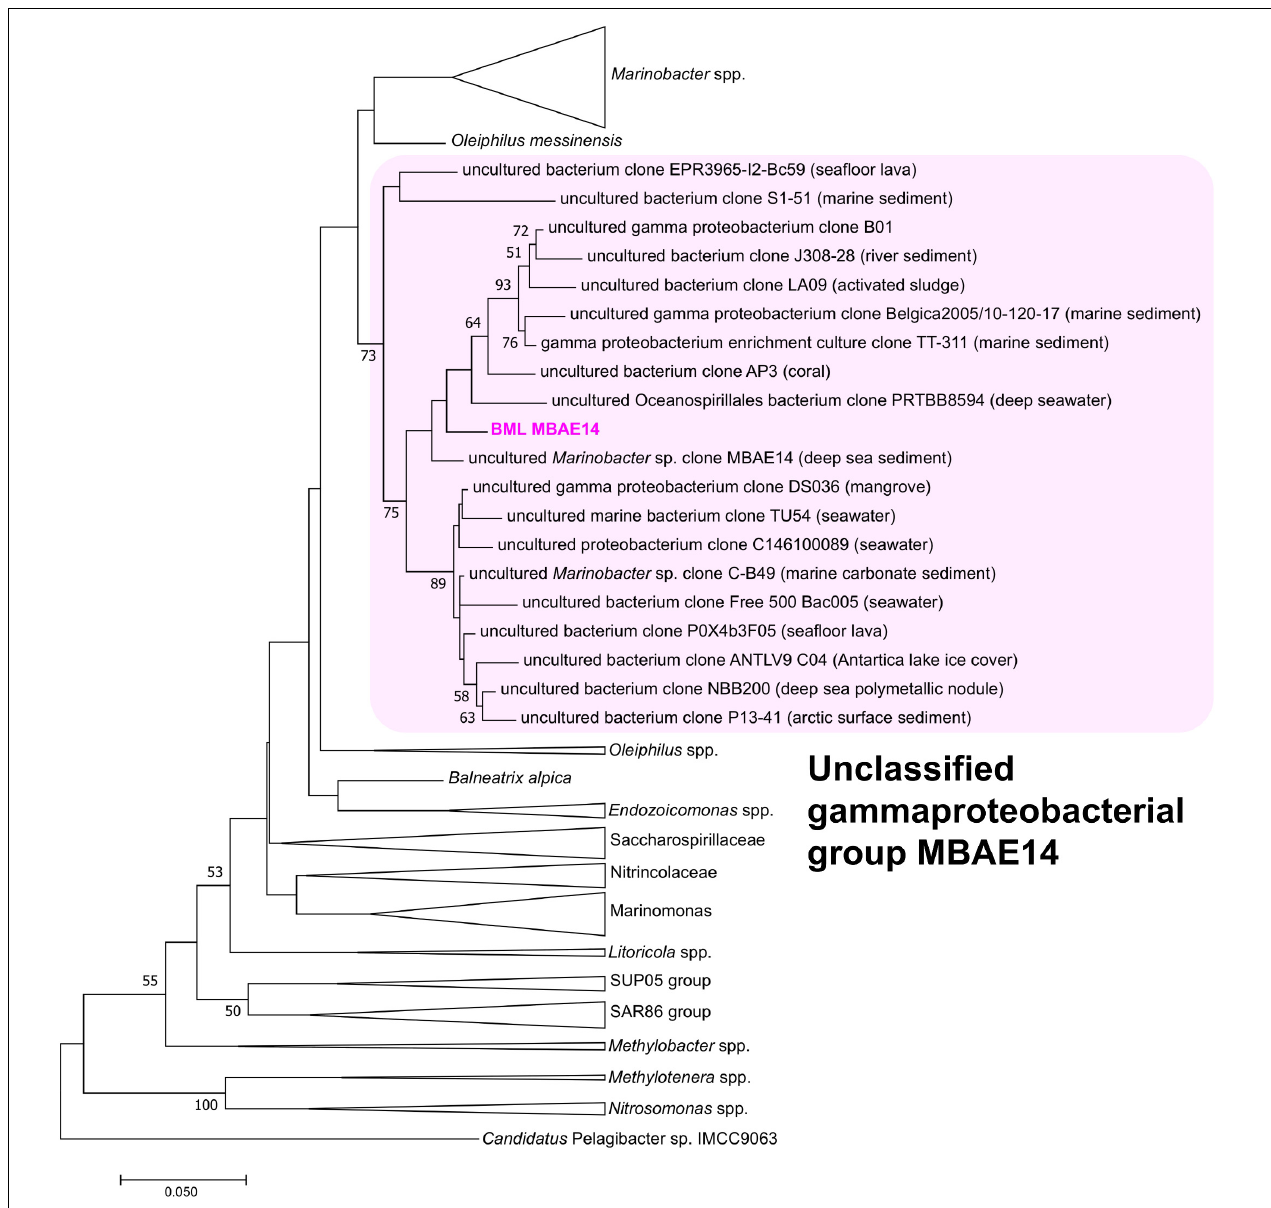
FIGURE 4 | Maximum-likelihood phylogenetic tree of 16S rRNA gene of the BML MBAE14 and phylogenetically-related bacterial groups. The tree was rooted with 16S rRNA gene of Candidatus Pelagibacter sp. IMCC9063 (SAR11 group, Alphaproteobacteria). The tree was created with 1000 bootstrap iteration (values below 50% are not reported). The origins of each uncultured bacterial clone belonging to the MBAE14 group are reported in parentheses.